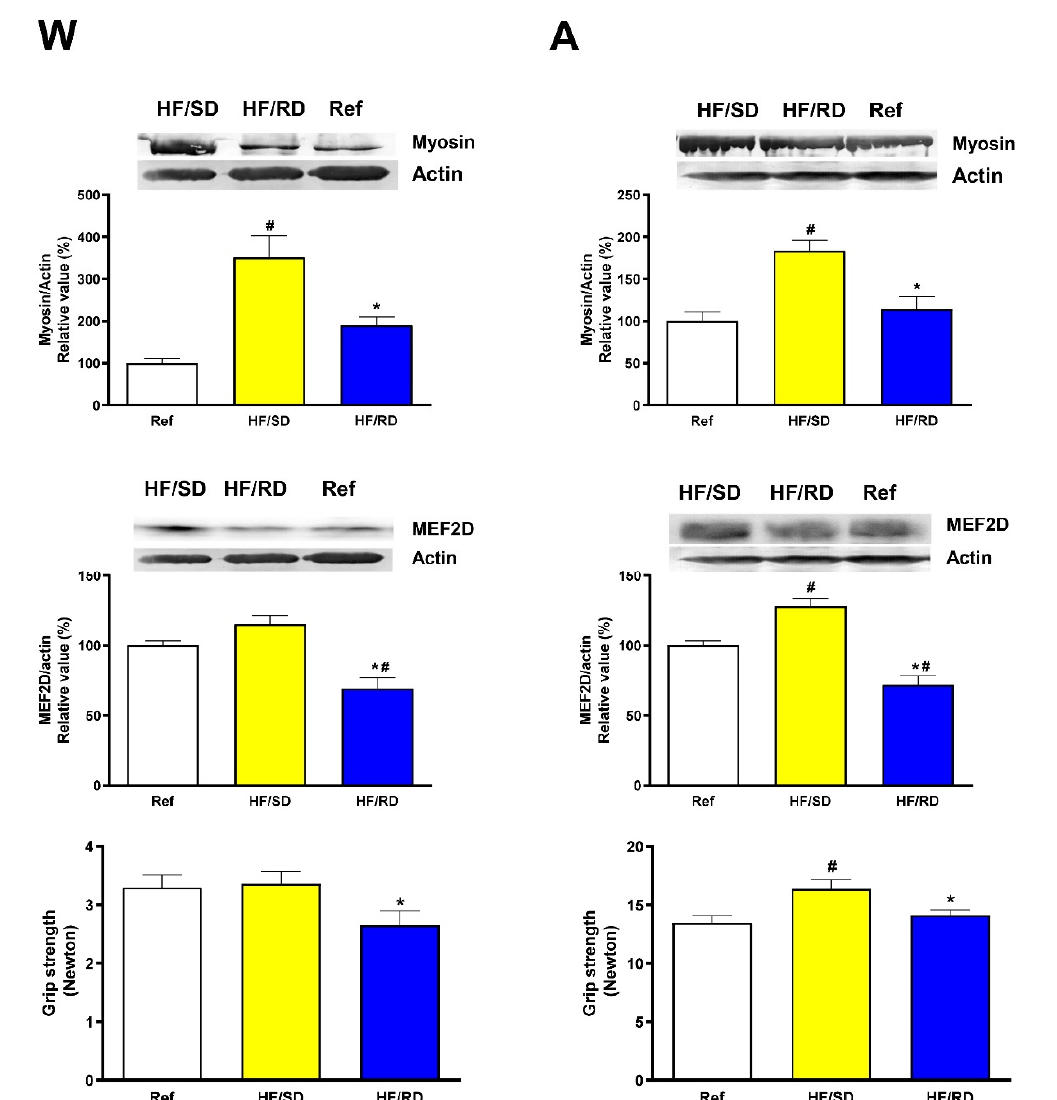
Figure 2. Muscle functionality in the offspring. Myosin content and grip strength were determined to address muscle functionality. MEF2D was measured as a marker of muscle differentiation at weaning ( W ) and adolescence ( A ). Values are means ± SEM ( n = 8 for each experimental group). HF/SD: offspring from mothers on high-fat diet containing slow digesting carbohydrates; HF/RD: offspring from mothers on high-fat diet containing rapid digesting carbohydrates; Ref: offspring from mothers on AIN93G diet. * Significant difference with HF/SD group, p < 0.05. # Significant difference with reference group, p < 0.05.